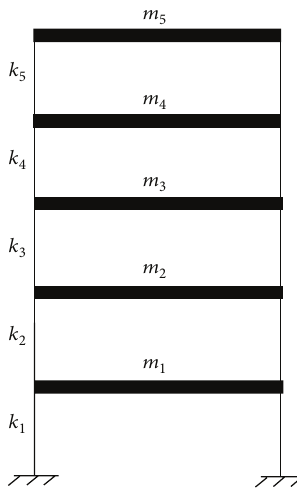
Figure 1: Elevation of a five-story building